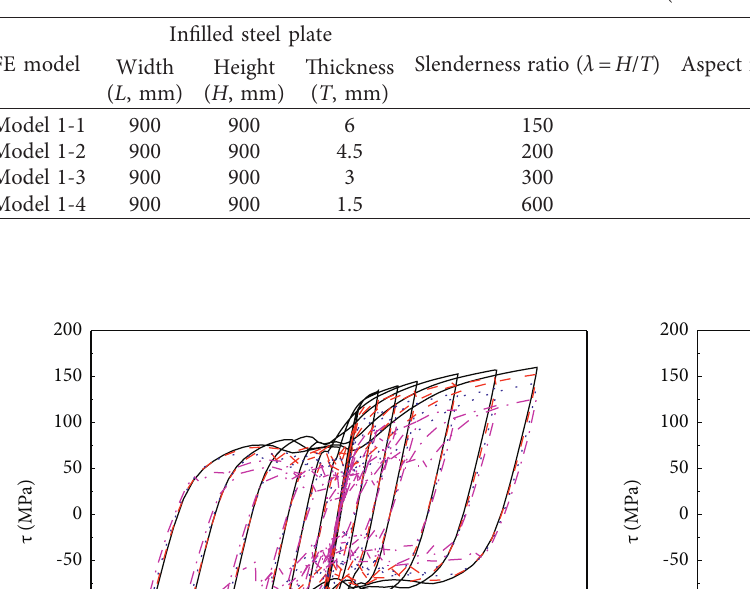
Figure 21: Comparison between test results and FE analysis results. (a) Hysteretic curves. (b) Skeleton curves. Table 9: Details of FE models (slenderness ratio).